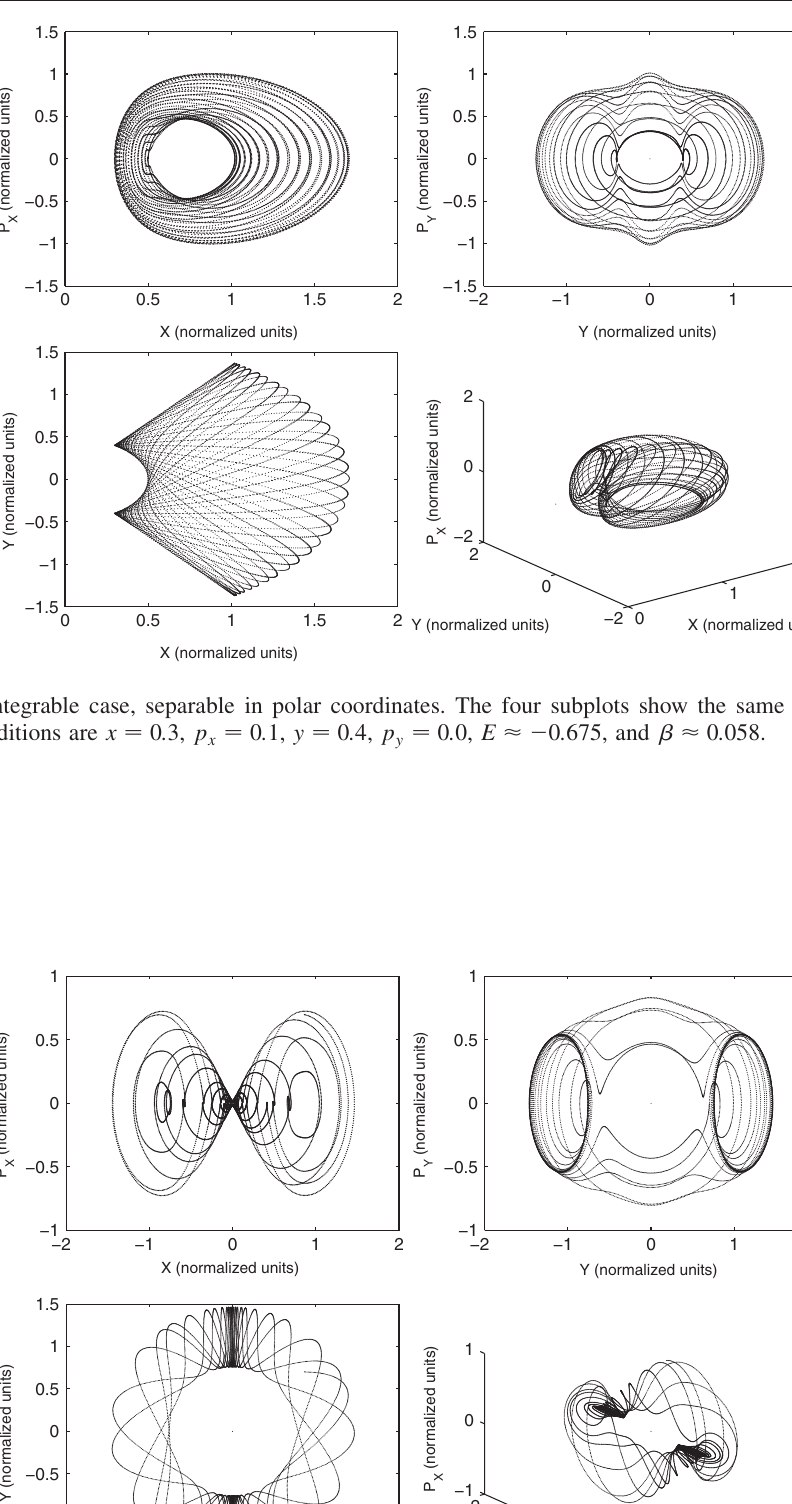
¼ 0 : 698 , y ¼ 0 : 7 , p ¼ 0 : 0 . E (cid:3) 0 : 962 , and (cid:1) (cid:3) 0 : 2004 . x y